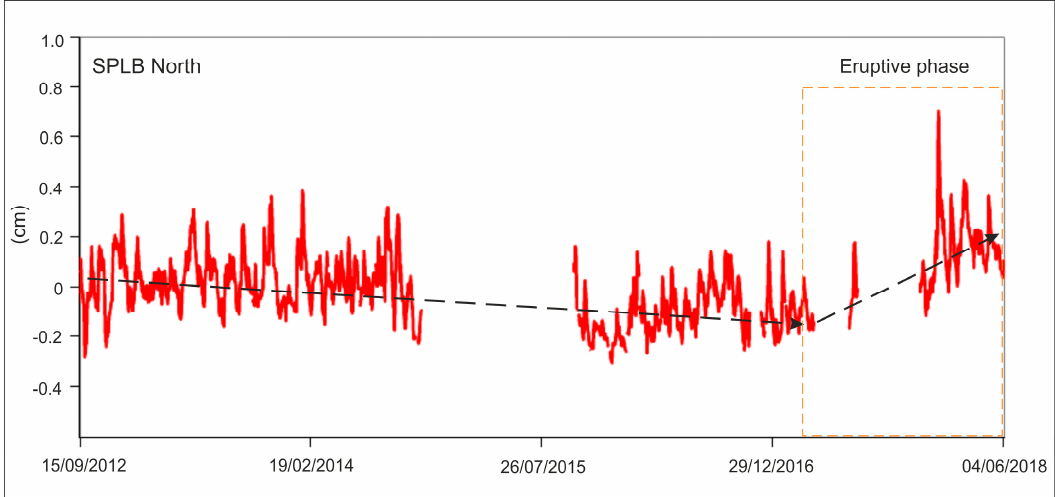
Figure 10. De-trended and filtered time series of the North − South component of the SPLB CGPS station. The second dashed black arrow indicates the increasing northward displacement of the station between 2016 and 2018. This displacement towards N (radial direction) is compatible with modest inflation of the volcano edifice.